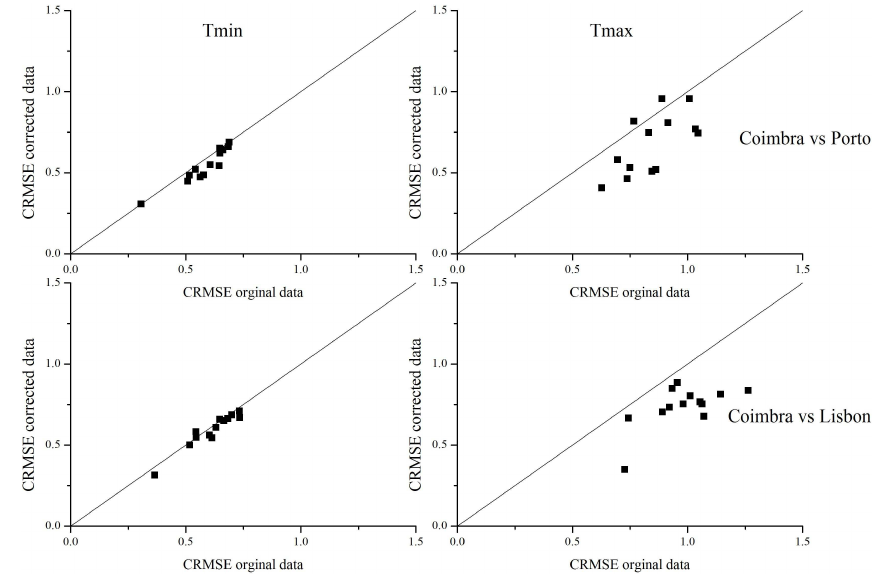
Figure 26. Coimbra: scatter plots of CRMSE before and after homogenization of 12 monthly and the annual series for T min (left) and T max (right). Corrected Porto (top panels) and Lisbon (bottom panels) temperature series are used as reference series. Dots on or below the bisect indicate data sets with unchanged or improved (increased) homogeneity, while dots above the bisect indicate data sets with increased